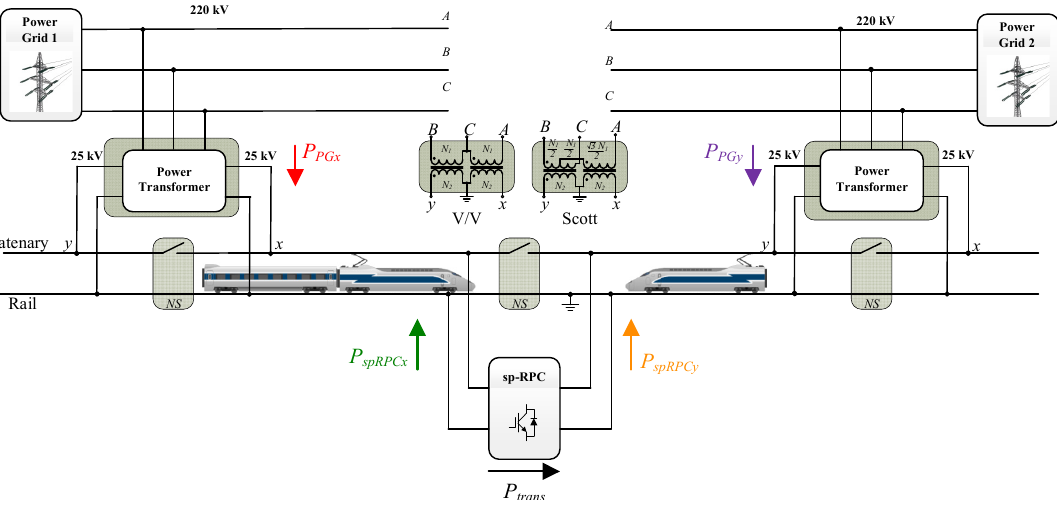
Figure 1. Electric railway system with the integration of the sp ‐ RPC.